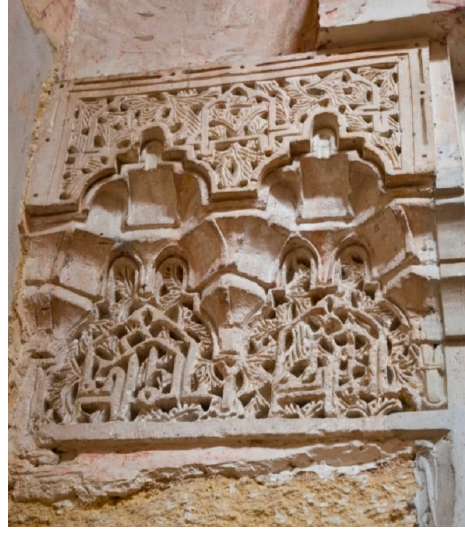
Figure 28. Arabic inscription on a muqarna decoration panel, Córdoba Synagogue. Author’s photo.